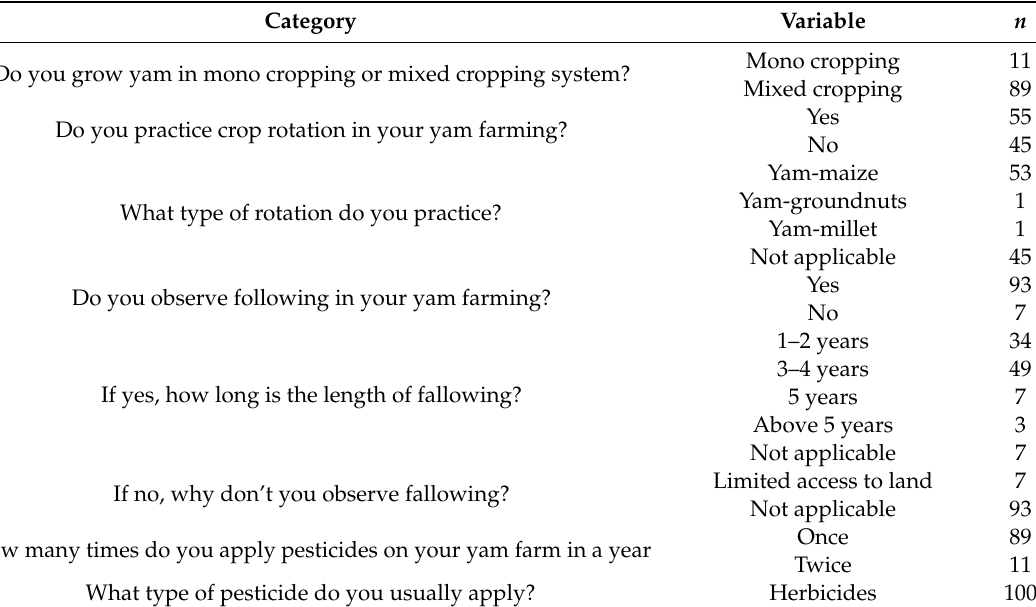
Table 2. System of yam farming.